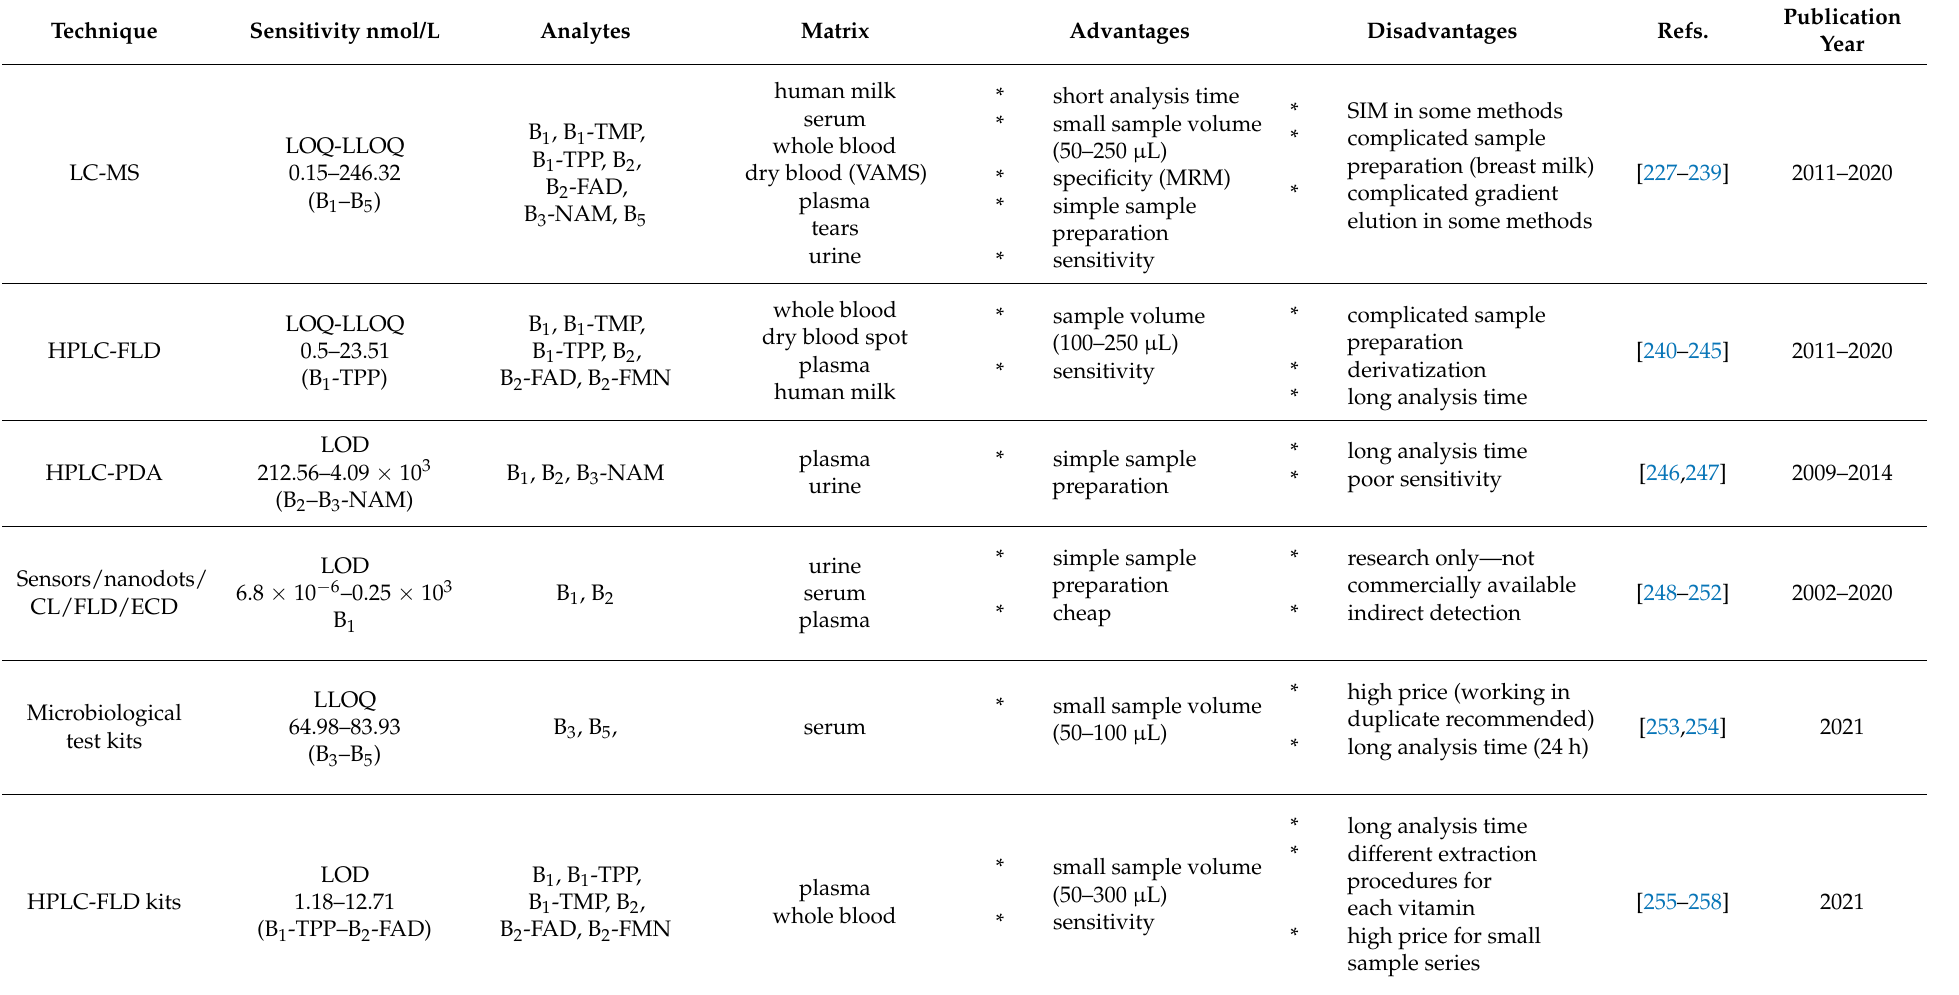
Table 3. Summary of methods for determination of vitamin B 1–5 in human biological